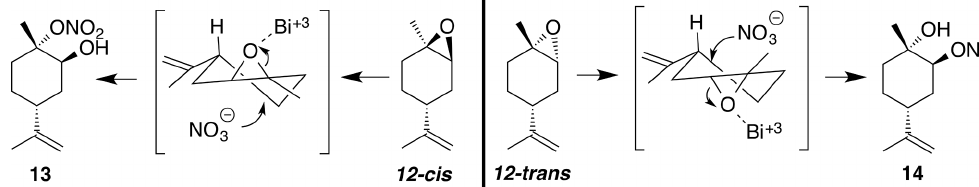
Figure 5. Nitration of cis - and trans -1,2-limonene oxide.